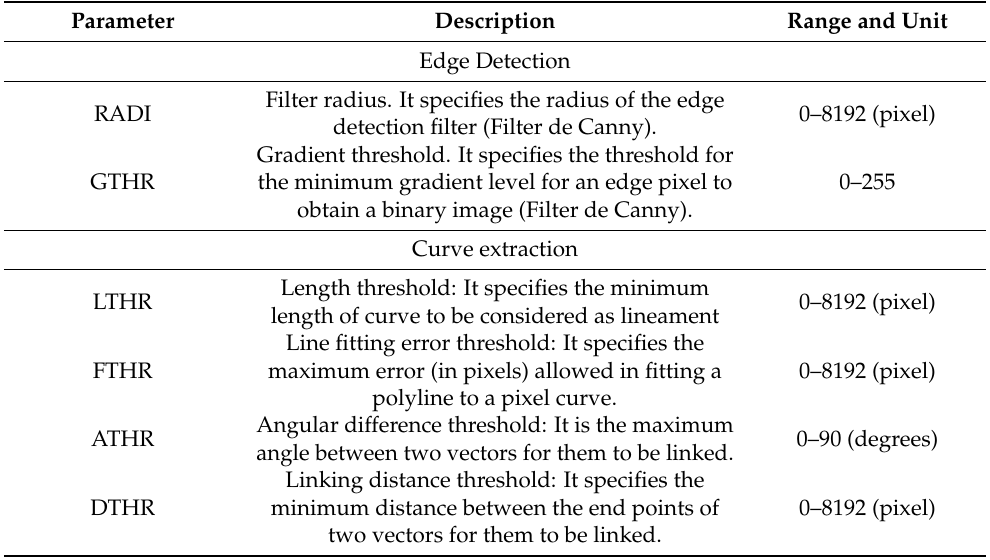
Table 4. Parameters used for the PCI Geomatica LINE module.